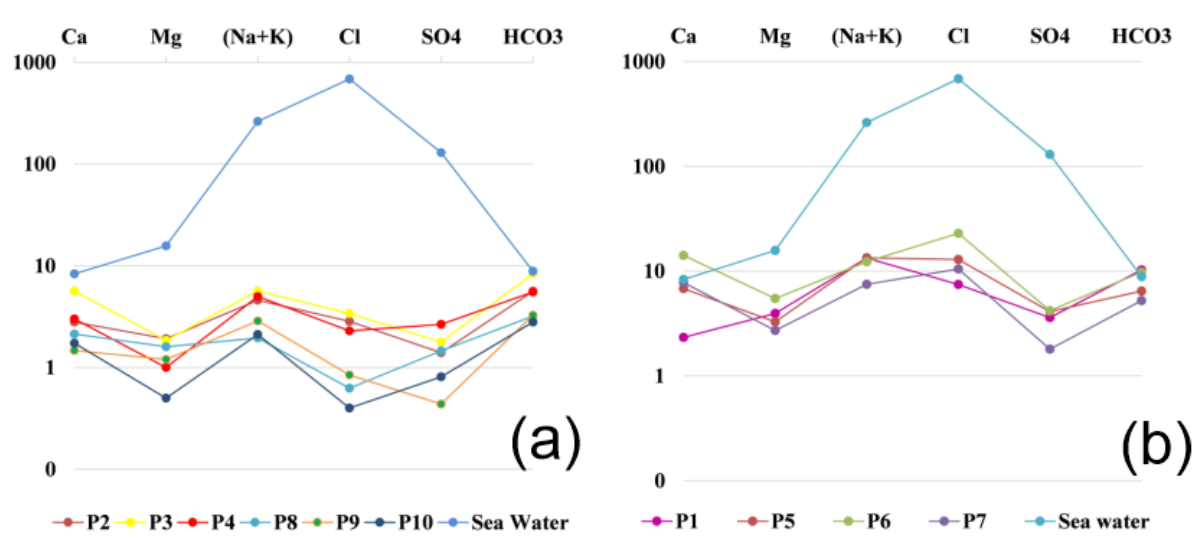
Figure 6. Schoeller diagrams with major elements ratios of groundwater (mg/L) from wells P2, P3, P4, P8, P9, and P10 ( a ) and P1, P5, P6, and P7 ( b ). Sea water composition is reported to better evaluate freshwater–saltwater interactions.